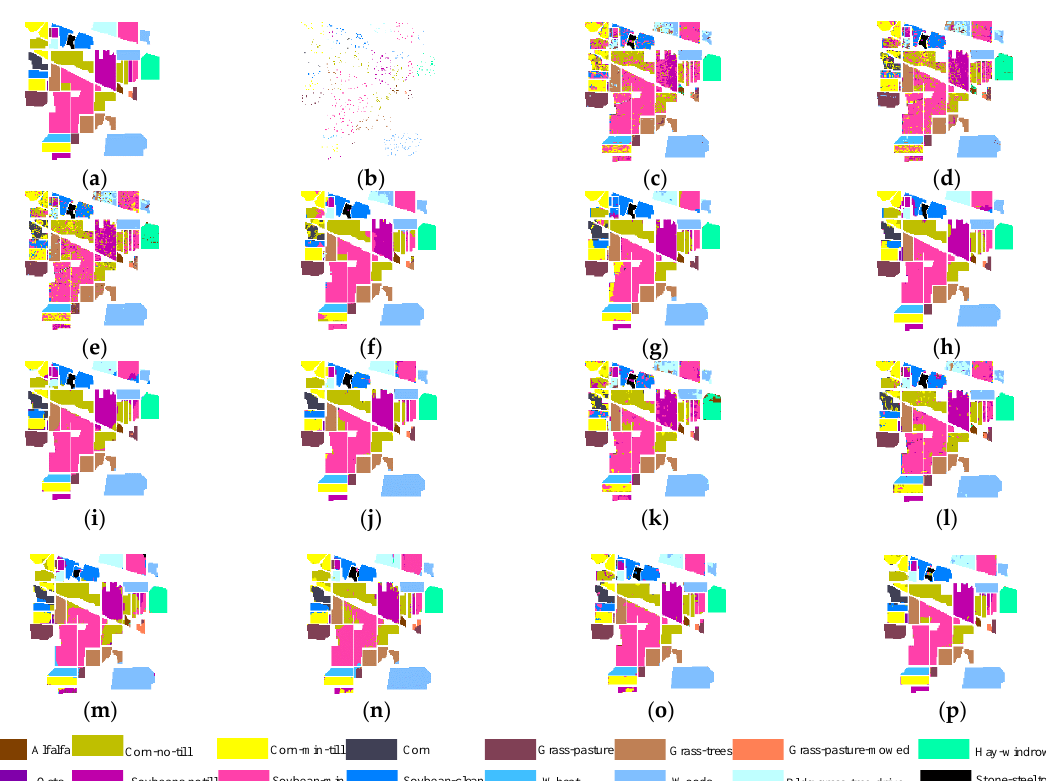
Figure 8. Classification maps of different methods on the Indian Pines dataset ( a ) ground; ( b ) training; ( c ) SVM, overall accuracy (OA) = 77.47%; ( d ) principal component analysis (PCA)-SVM, OA = 77.81% ( e ) large margin distribution machine (LDM), OA = 79.85%; ( f ) PCA-LDM, OA = 78.49%; ( g ) edge-